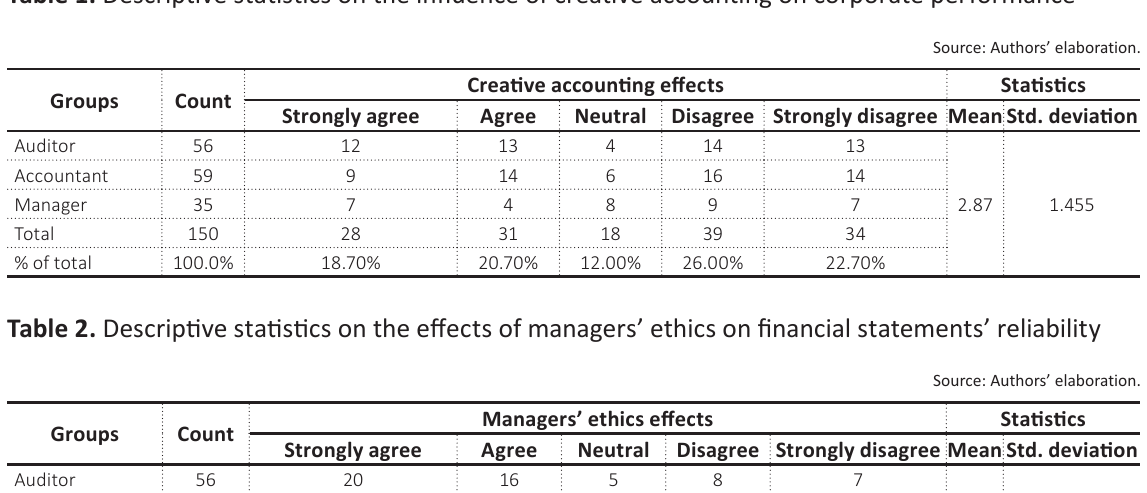
Source: Authors’ elaboration.